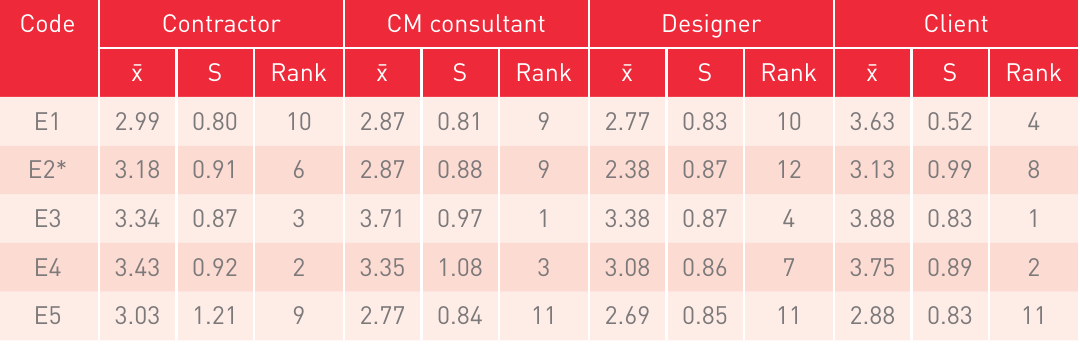
Barriers according to construction practitioners Code